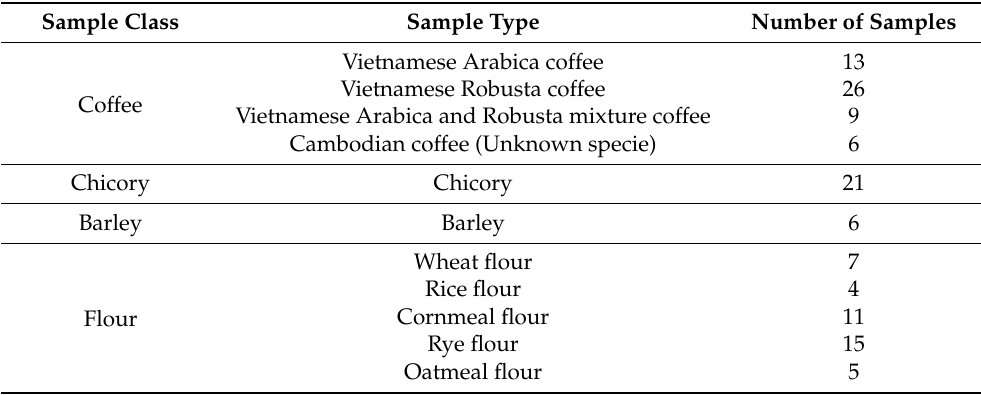
Table 1. Summary of the analyzed